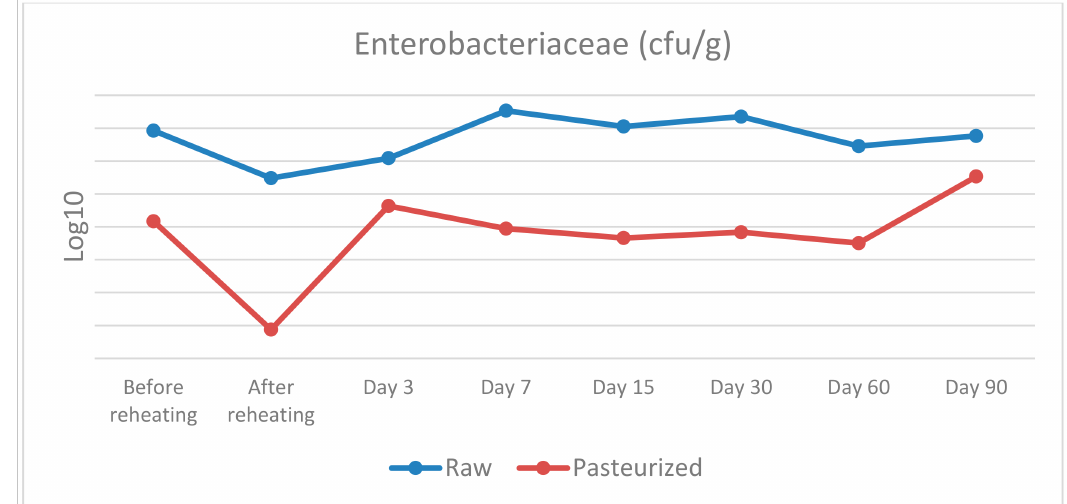
Figure 1. Enterobacteriaceae counts in raw and pasteurized curd and cheese samples.